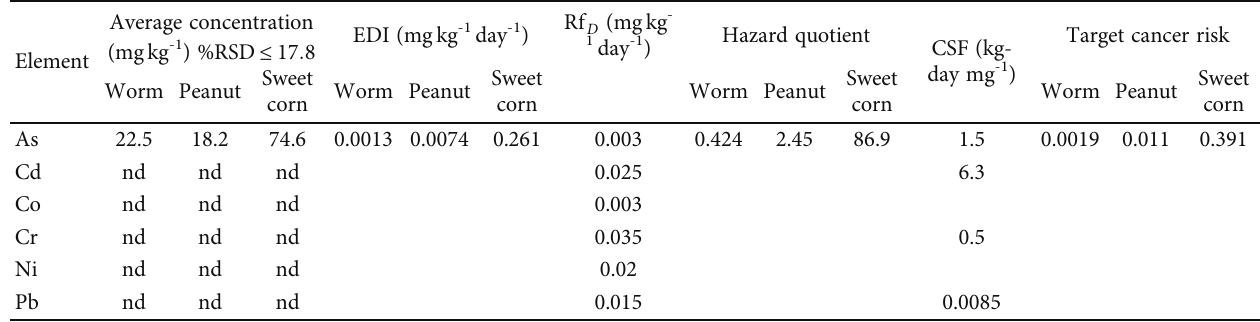
Table 4: Heavy metal concentrations and health risk assessment